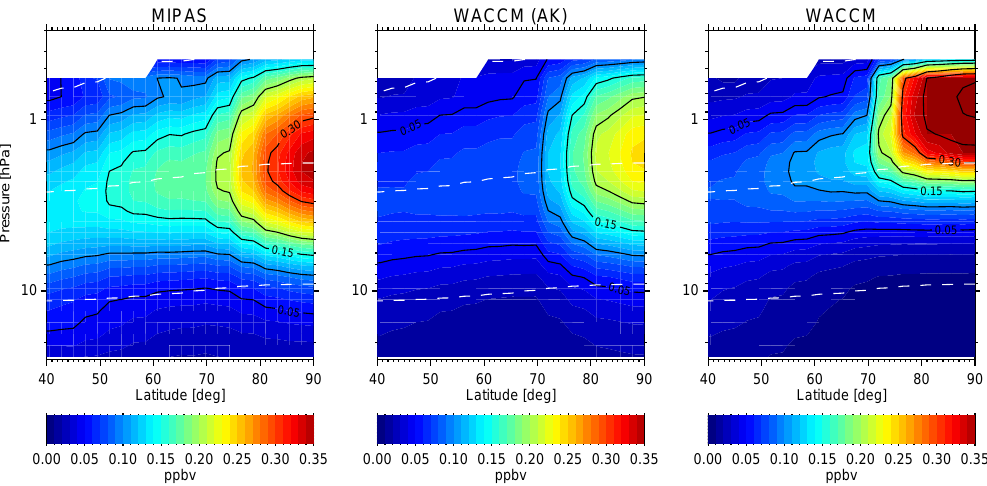
Fig. 6. Effect of application of averaging kernels (AKs) to the model data on the example of MIPAS and WACCM4 HOCl zonal mean distributions (40–90 ◦ N) averaged over the period 29 October to 4 November 2003. Left: MIPAS, middle: WACCM4 with MIPAS averaging kernels applied, right: WACCM4, original model results.